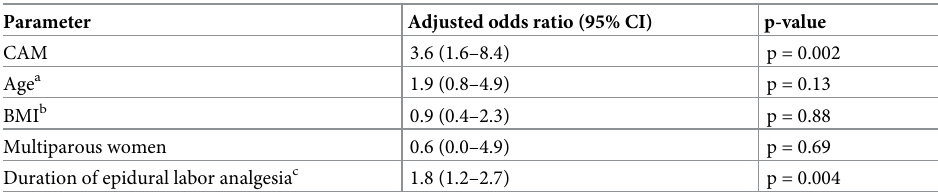
Table 4. Primary outcome; multivariable logistic regression analysis.